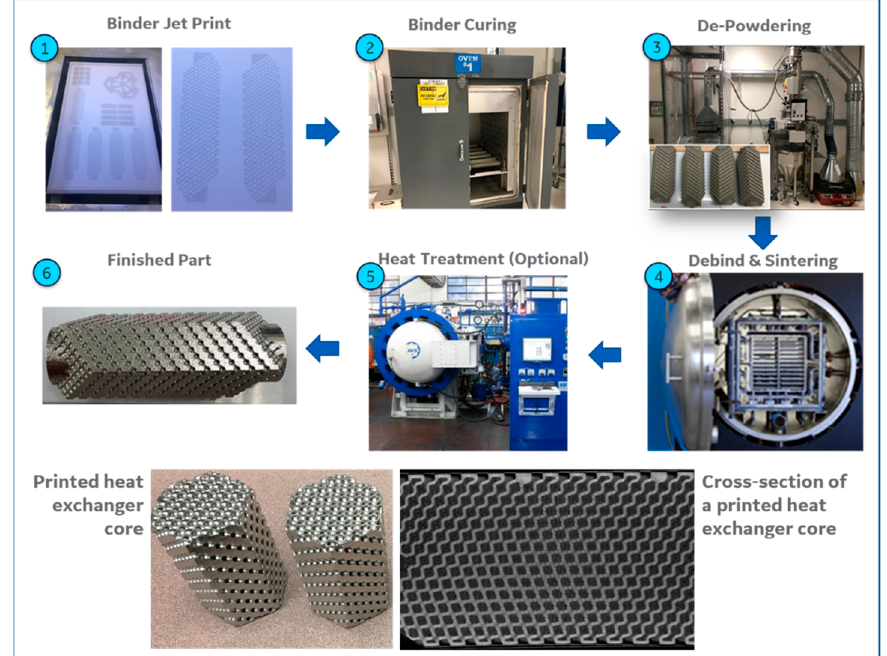
Figure 2. Overall BJAM process—printing, curing, de-powdering, and sintering steps. The two images at the bottom of the figure show the printed and sintered core, and a cross-section of the heat exchanger’s internal flow passages. Reprinted/adapted with permission from [4]. Copyright—2020, General Electric.